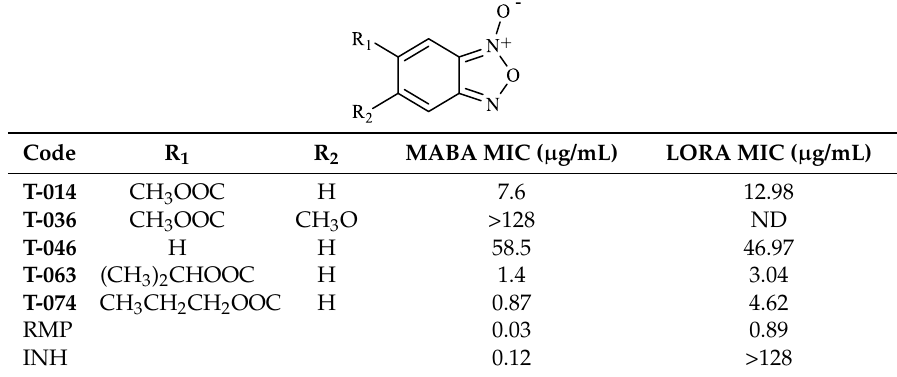
Table 1. Biological activity of benzofuroxane N -oxide derivatives using the microplate Alamar blue assay (MABA) against Mycobacterium tuberculosis strain H37Rv and the low oxygen recovery assay (LORA) against the nonreplicating persistent strain.